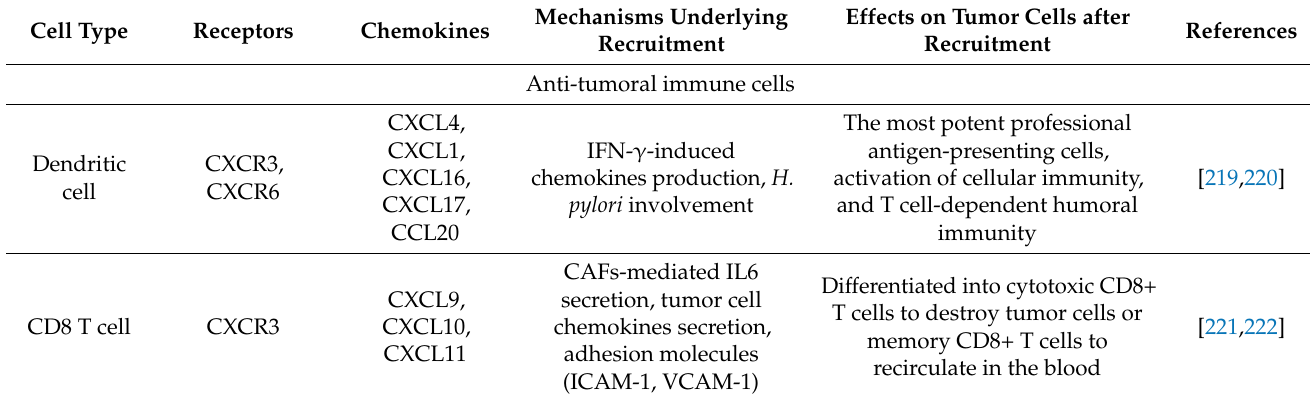
Table 2. Immune cell infiltration induced by chemokine and related